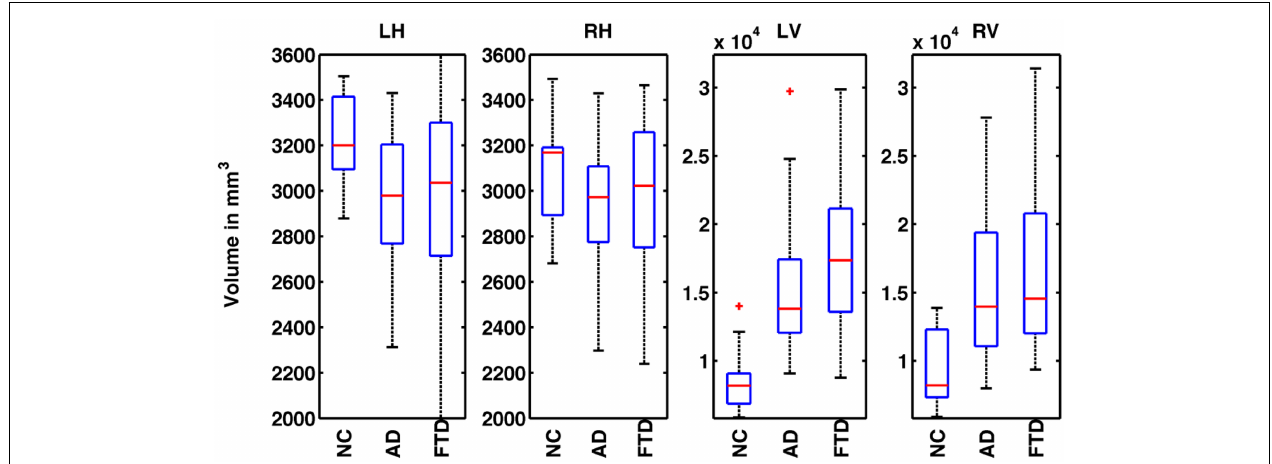
FTD and AD volumes overlap and hence, FTD and AD individuals cannot be discriminated based on hippocampal volumes alone. In the plots 3 and 4, the distributions of ventricular volumes for FTD and AD are slightly above that of NC reflecting ventricular expansion.The distributions of FTD and AD volumes overlap, hence FTD and AD individuals cannot be discriminated based on ventricular volumes alone.